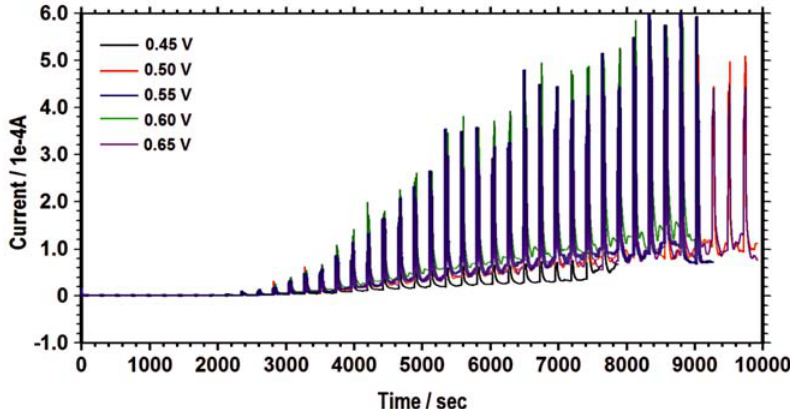
Figure 4. Amperometric I–t curves recorded for determination of HQ over PANI – P3MT – PDAB coated Pt electrode at different potentials (0.45 V – 0.65 V, vs.